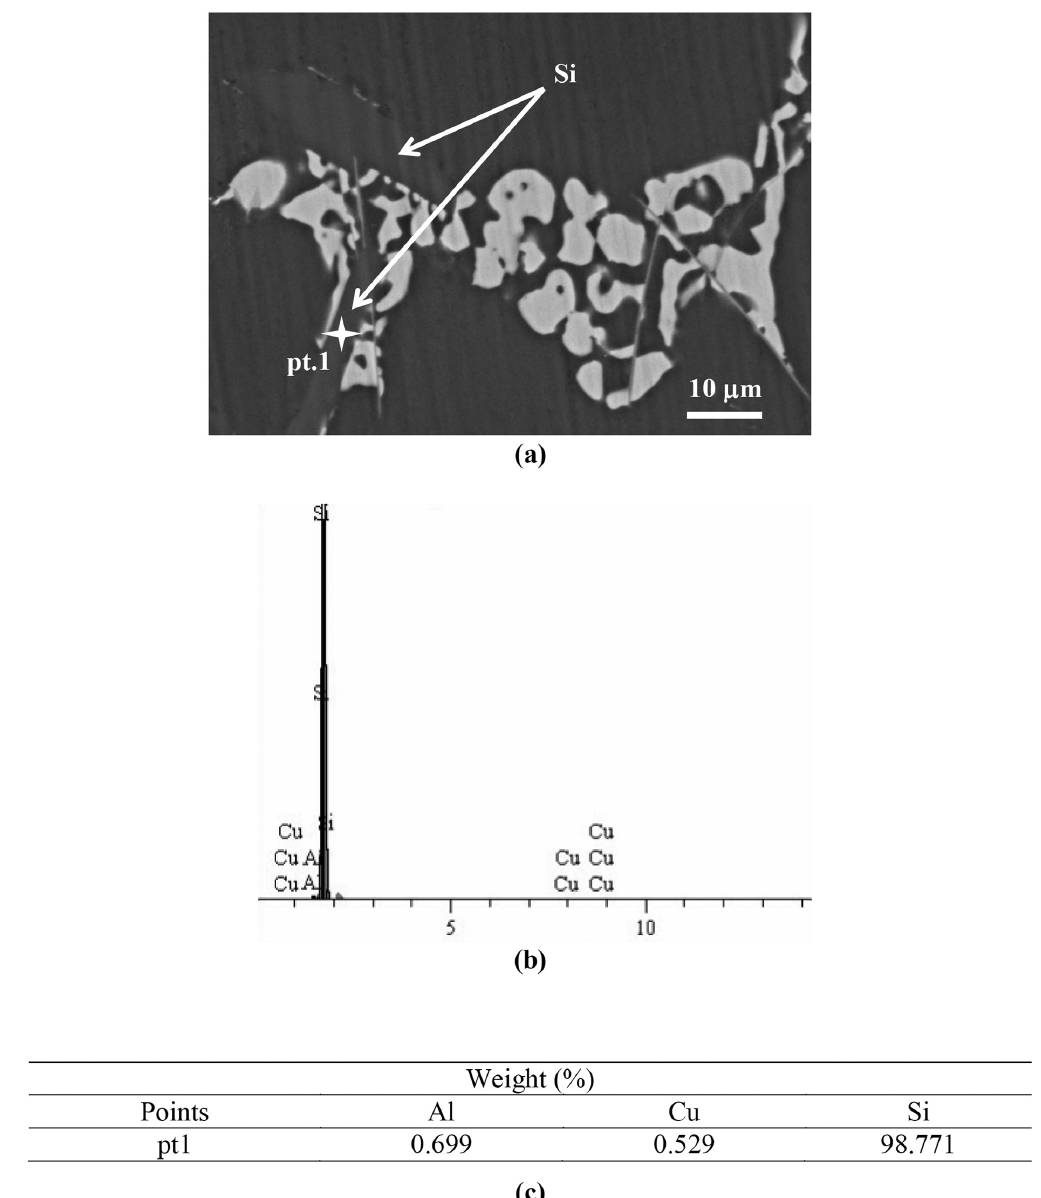
Figure 7 - Typical SEM micrograph and EDAX patterns of a Al-6wt.%Cu-8wt.%Si alloy sample at 70 mm (V = 0.28 mm/s, T = 0.71 K/s and λ = 336.2 μ m) from the cooled surface of the casting for Al-6wt.%Cu- L R 1 8wt.%Si alloy: ( a ) Accelerating Voltage: 20 kV and Magni fi cation: 200; ( b ) Accelerating Voltage: 20 kV and Magni fi cation: 1500; ( c ) EDAX patterns and the corresponding chemical composition on a Si